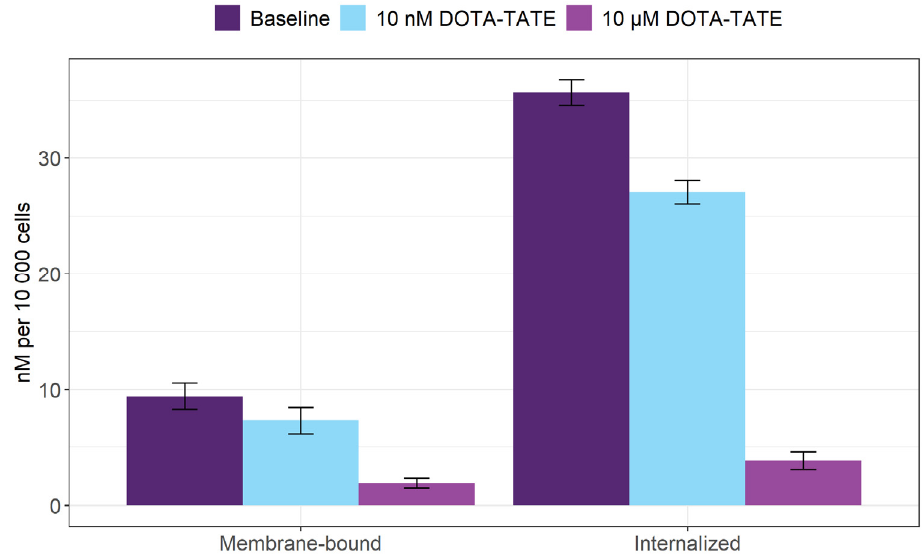
Figure 2. [ 153 Sm]Sm-DOTA-TATE is internalized by SSTR 2 -expressing CA20948 cells. Values represent mean ± standard deviation.